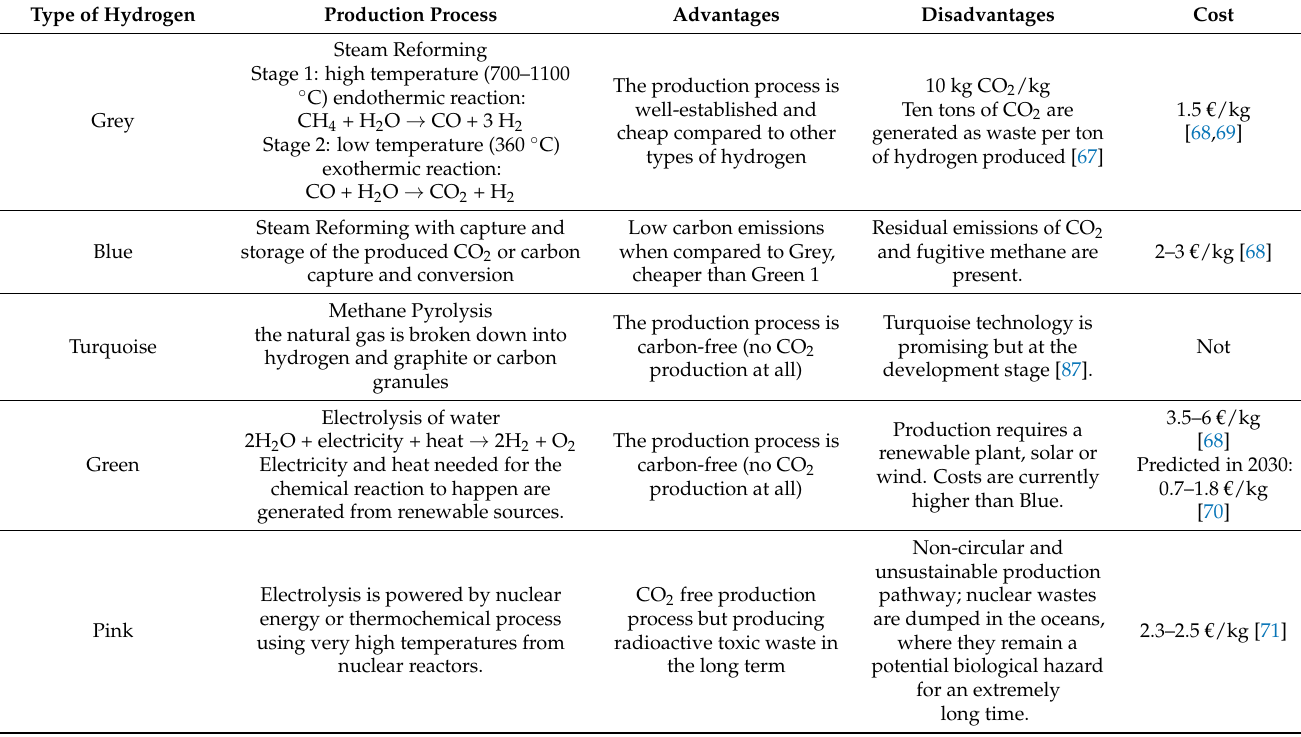
Table 2. Types of